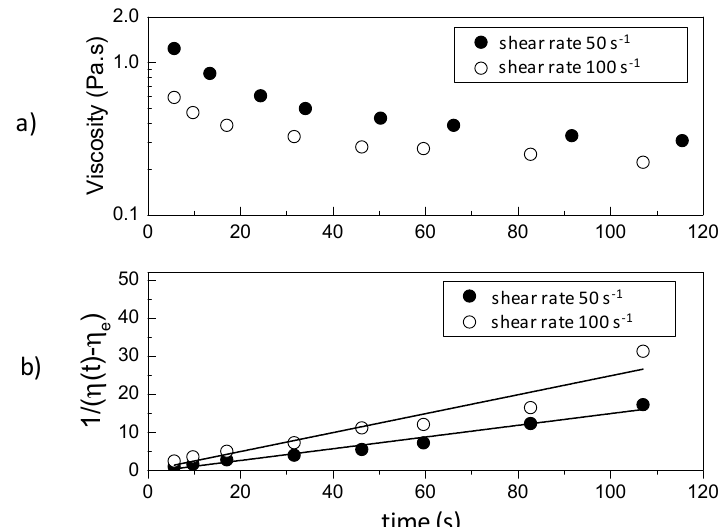
Figure 1. ( a ) Typical thixotropic behavior of a rheological time dependent gel after the application of constant shear rates of 50 1/s and 100 1/s; ( b ) schematic of the approach used to determine the parameters defining the structural parameter λ silica gel.